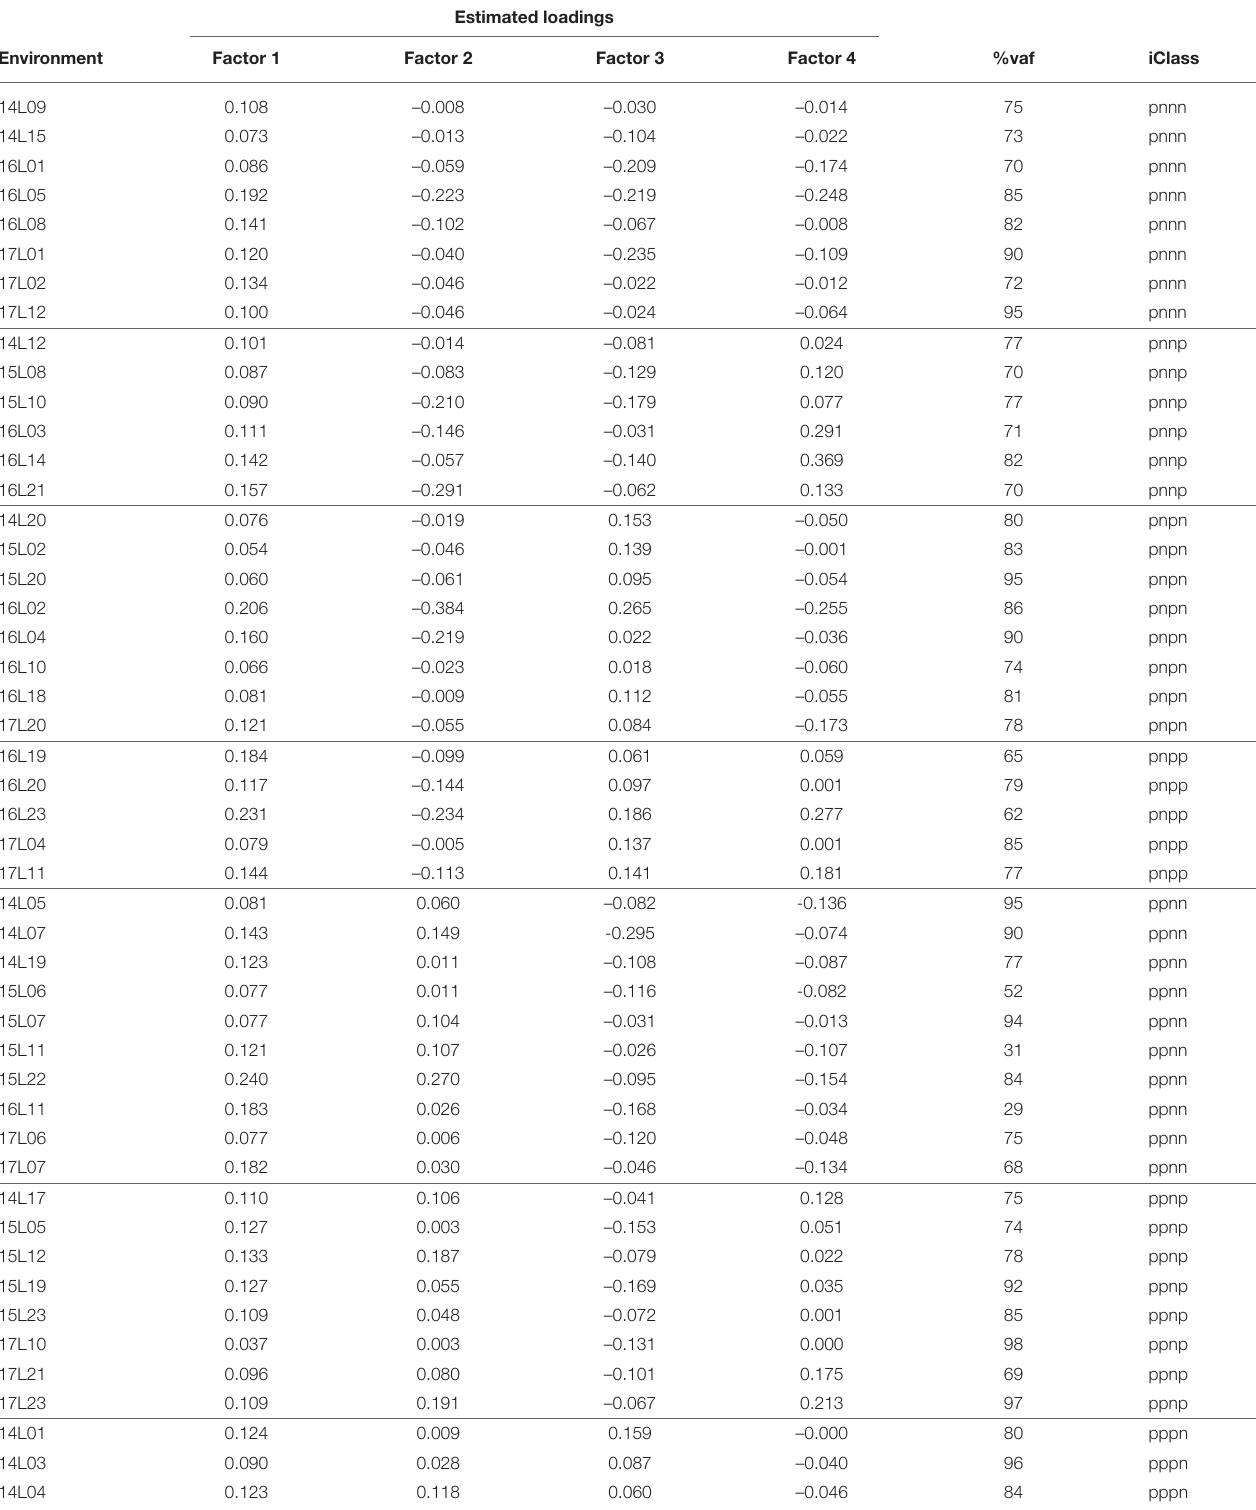
TABLE 4 | Summary of environment information from FA4 model fitted to VE effects: rotated REML estimates of loadings for each factor and percentage variance accounted for by all four factors. Estimated